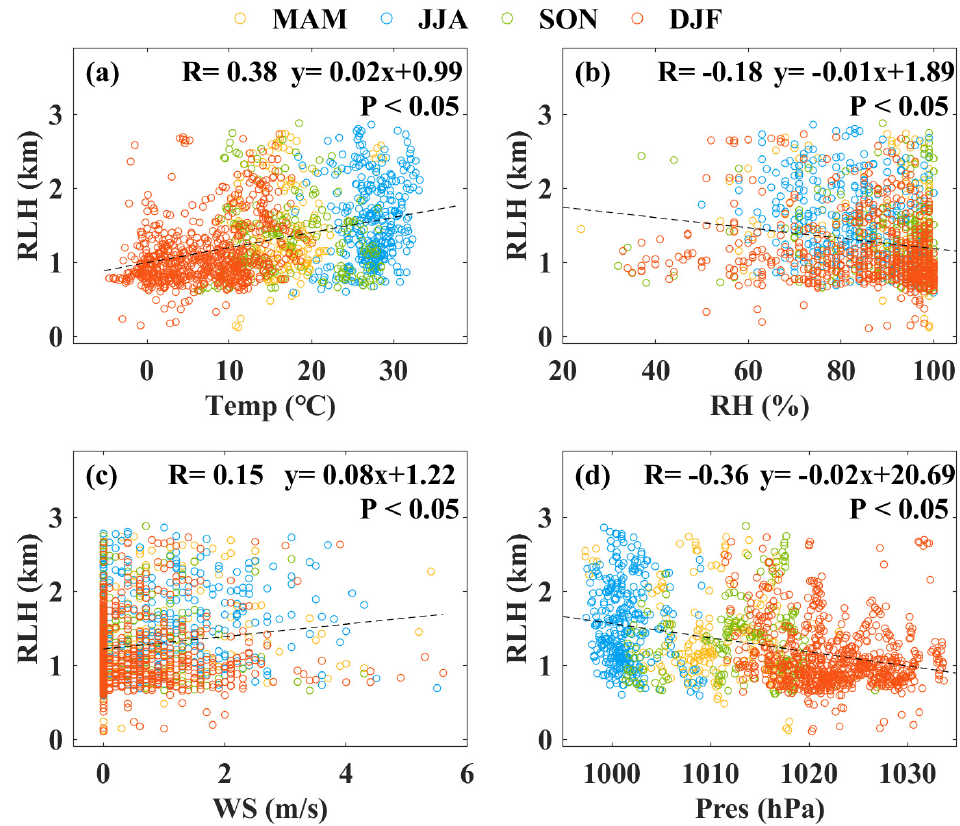
Figure 5. Correlations between different surface meteorological parameters and the RLH over Wuhan: ( a ) Temp; ( b ) RH; ( c ) WS; and ( d ) Pres. Statistical samples are hourly mean data. Black dotted line represents the linear fitting curve. Correlation coefficients (R) and fitted function are provided in the top of each panel. Yellow, blue, green, and red dots represent spring, summer, autumn, and winter, respectively.